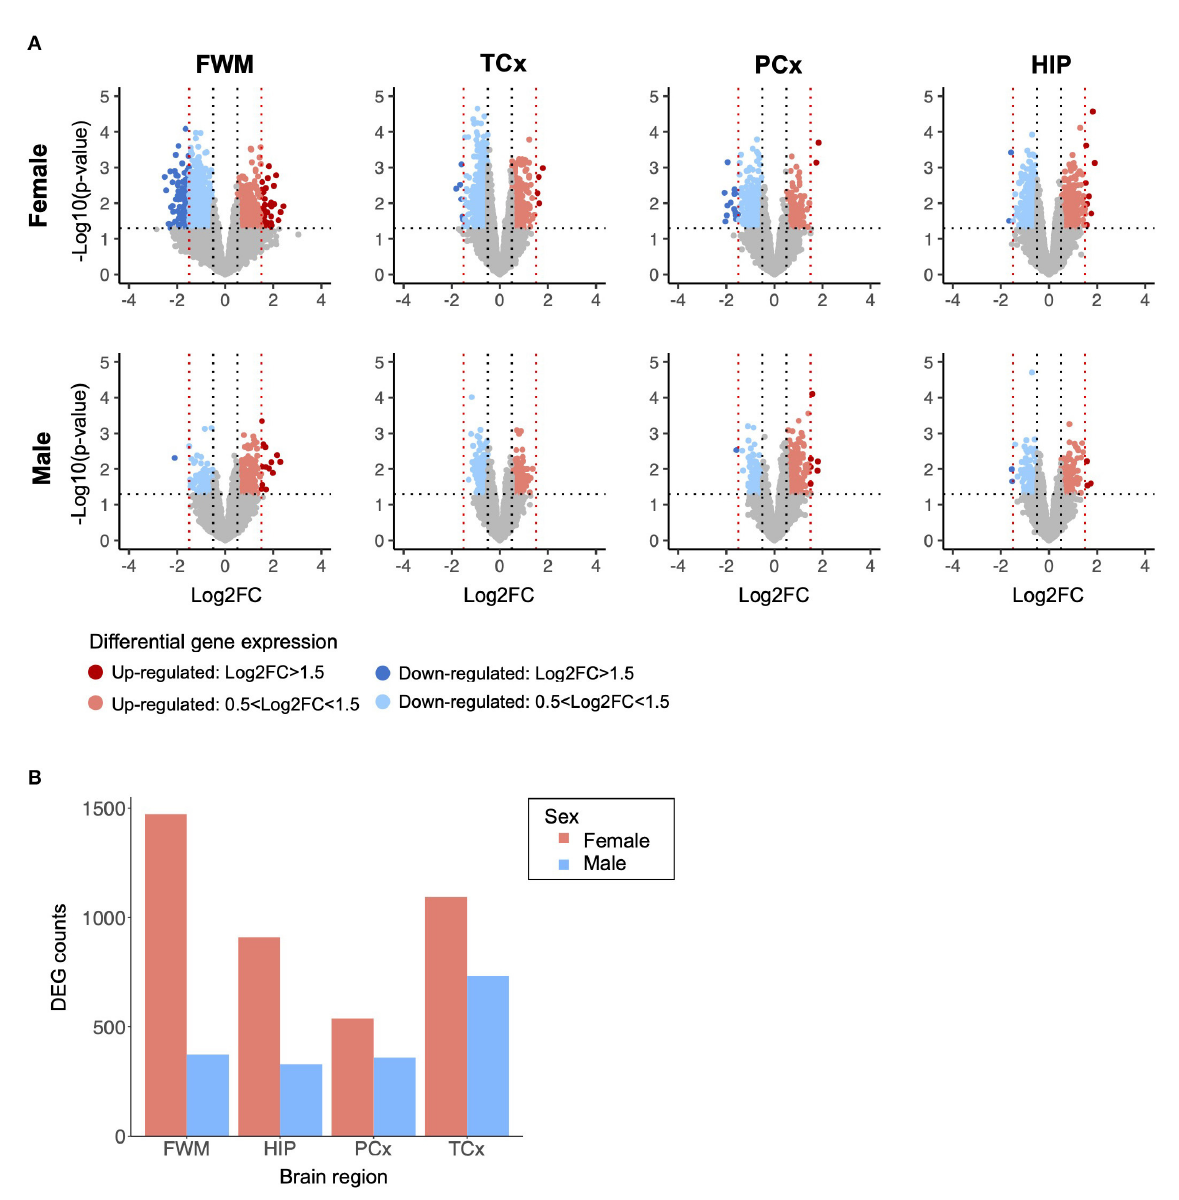
FIGURE1 Differential gene expression analysis stratified by brain region and sex. (A) Differentially expressed genes (DEGs) identified in traumatic brain injury (TBI) donor samples and controls, analyzed independently for each brain region and sex. The threshold for nominal significance was set at p -value < 0.05 and |log2 fold change| > 0.5. The red nodes represent significantly upregulated genes, and the blue nodes represent significantly down-regulated genes. The black and red vertical dotted lines represent a log2 fold change of ± 0.5 and ± 1.5, respectively. The horizontal dotted line represents a p- value of 0.05. Nominally significant DEGs were subject to independent weighted co-expression network analyses (WGCNA). (B) Sum of DEG counts identified in TBI donor samples and controls from each brain region, stratified by sample sex. DEG, differentially expressed genes; FC, fold change; FWM, frontal white matter; HIP, hippocampus; PCx, parietal neocortex; TCx, temporal